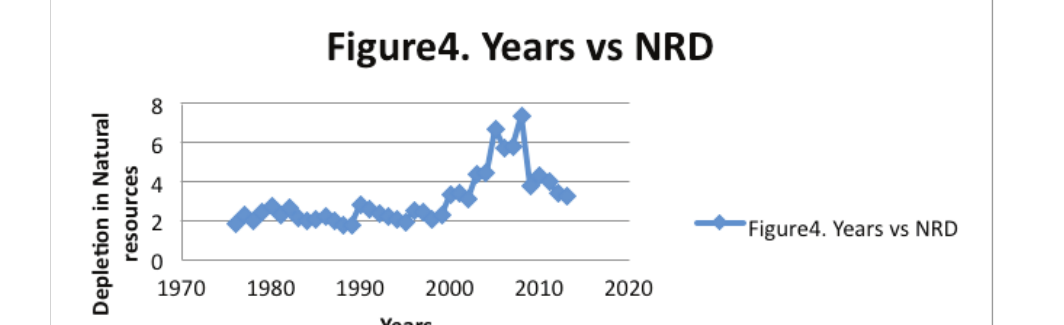
Source: World Development Indicators of